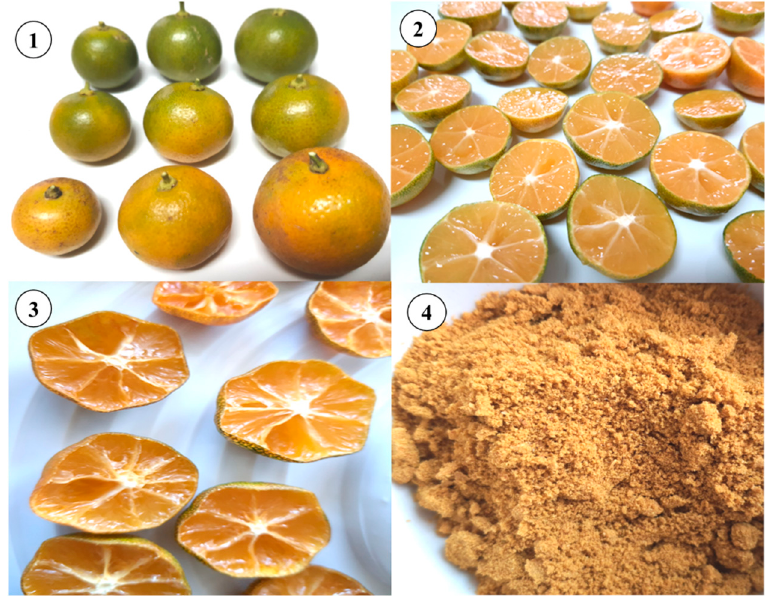
Figure 4. Calamondin powder: ( 1 ) grading, ( 2 ) cutting and removing seeds, ( 3 ) after dehydration, and ( 4 ) powder after using a grinder.